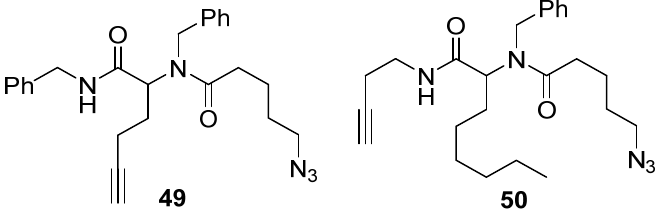
Figure 2. Ugi dipeptide products that failed to undergo IAAC.